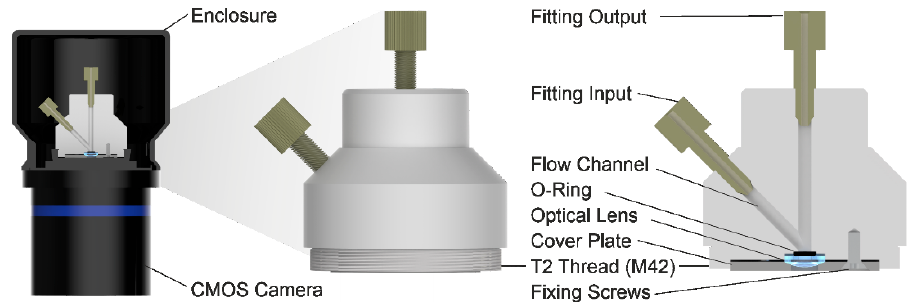
Figure 3. Flow cell design for chemiluminescence detection. The flow cell was manufactured from POM, and the enclosure was made from ABS.